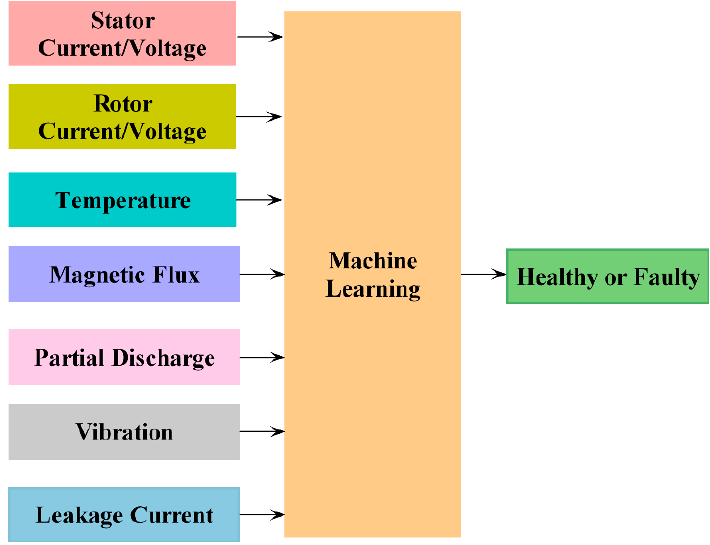
Figure 4. Use of machine learning technique in power distribution systems